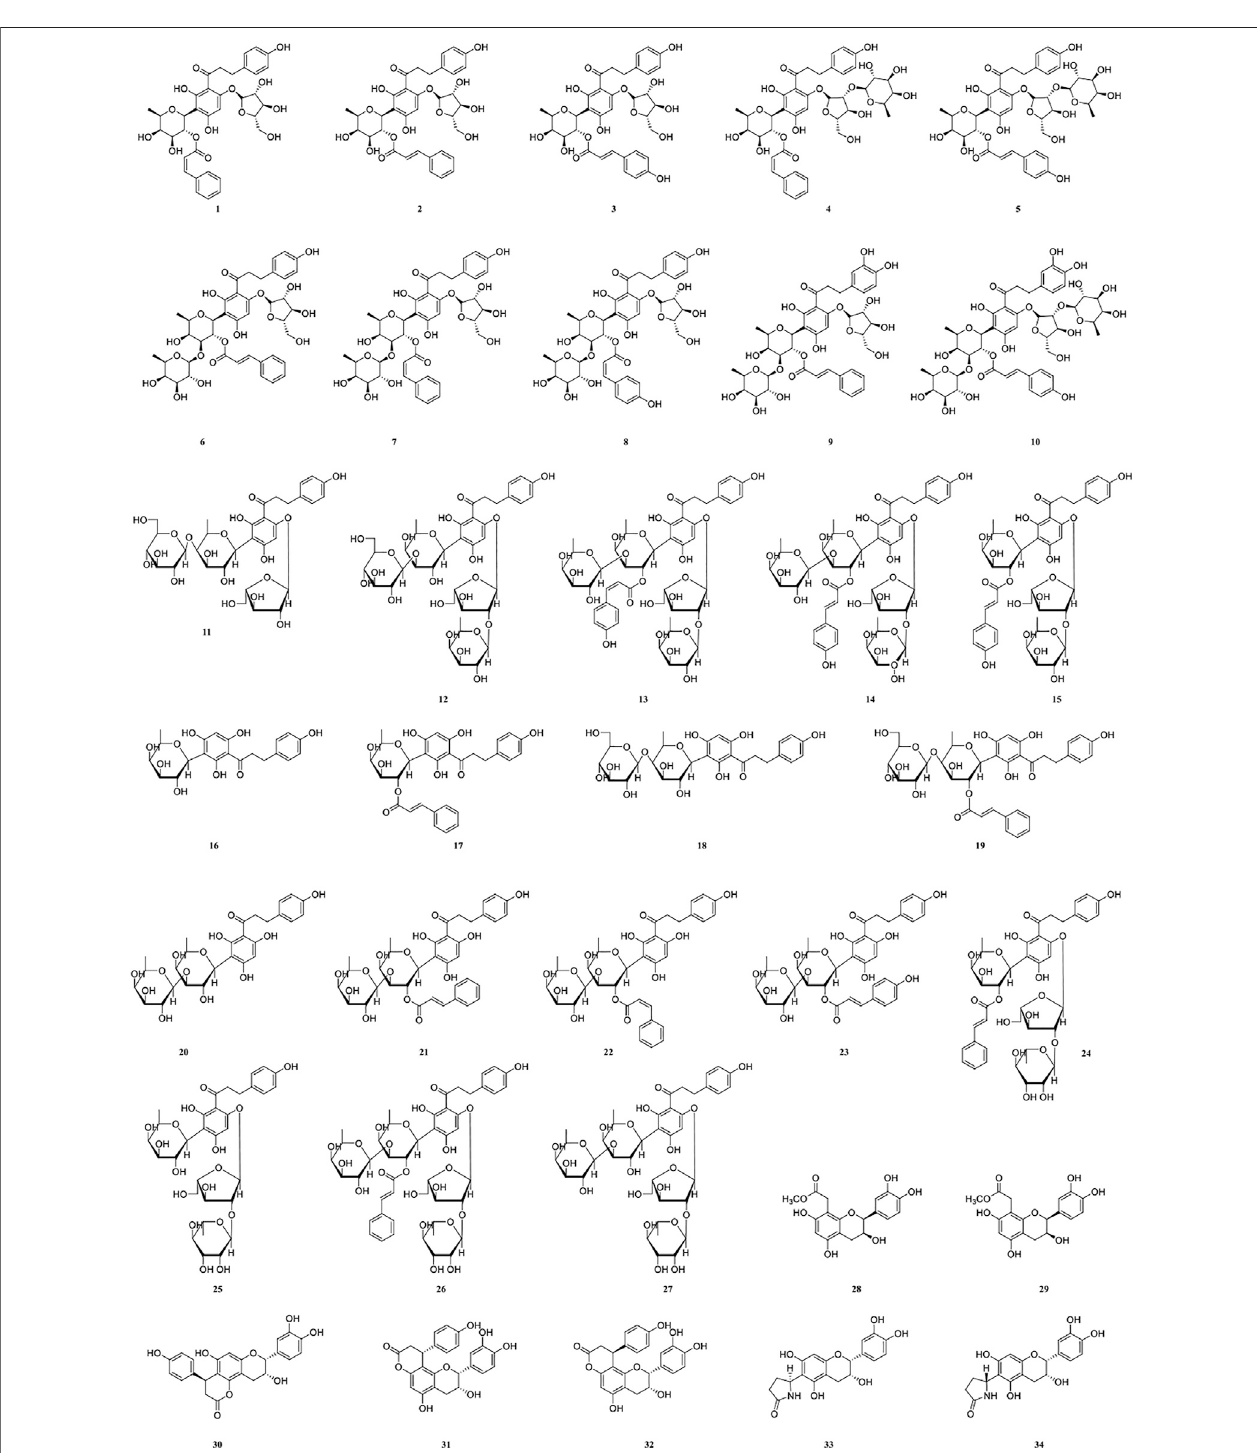
FIGURE 3 | Chemical structures of compounds isolated from A. carambola .